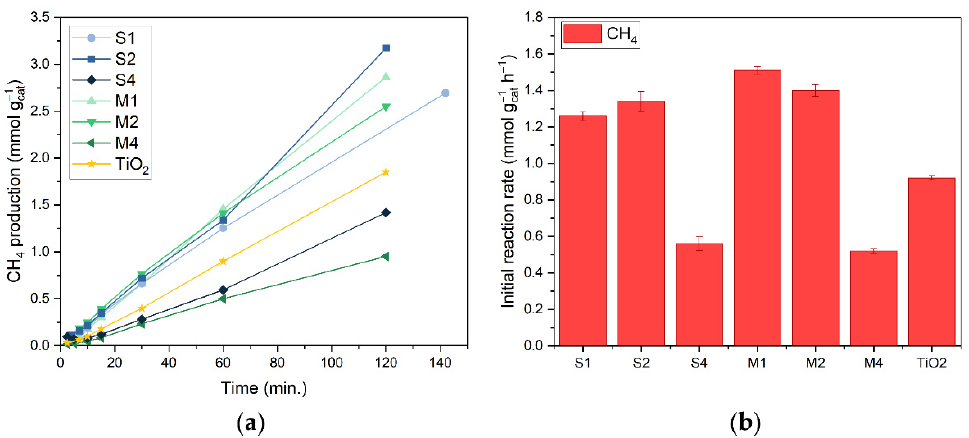
Figure 4. ( a ) CH4 production of bare TiO2, M1–4 and S1–4 catalysts in the dark per gram of catalyst powder; ( b ) initial reaction rates of bare TiO2, S1–4 and M1–4 catalysts for CH4 production in dark while no CO production was observed. Error bars represent a 98% confidence interval. Connecting lines are a guide to the eye. Reaction conditions: mixture of CO2:H2:N2 (2:2:1) at 3.5 bar pressure, 200 mg catalyst, dark conditions (160 °C catalyst temperature).